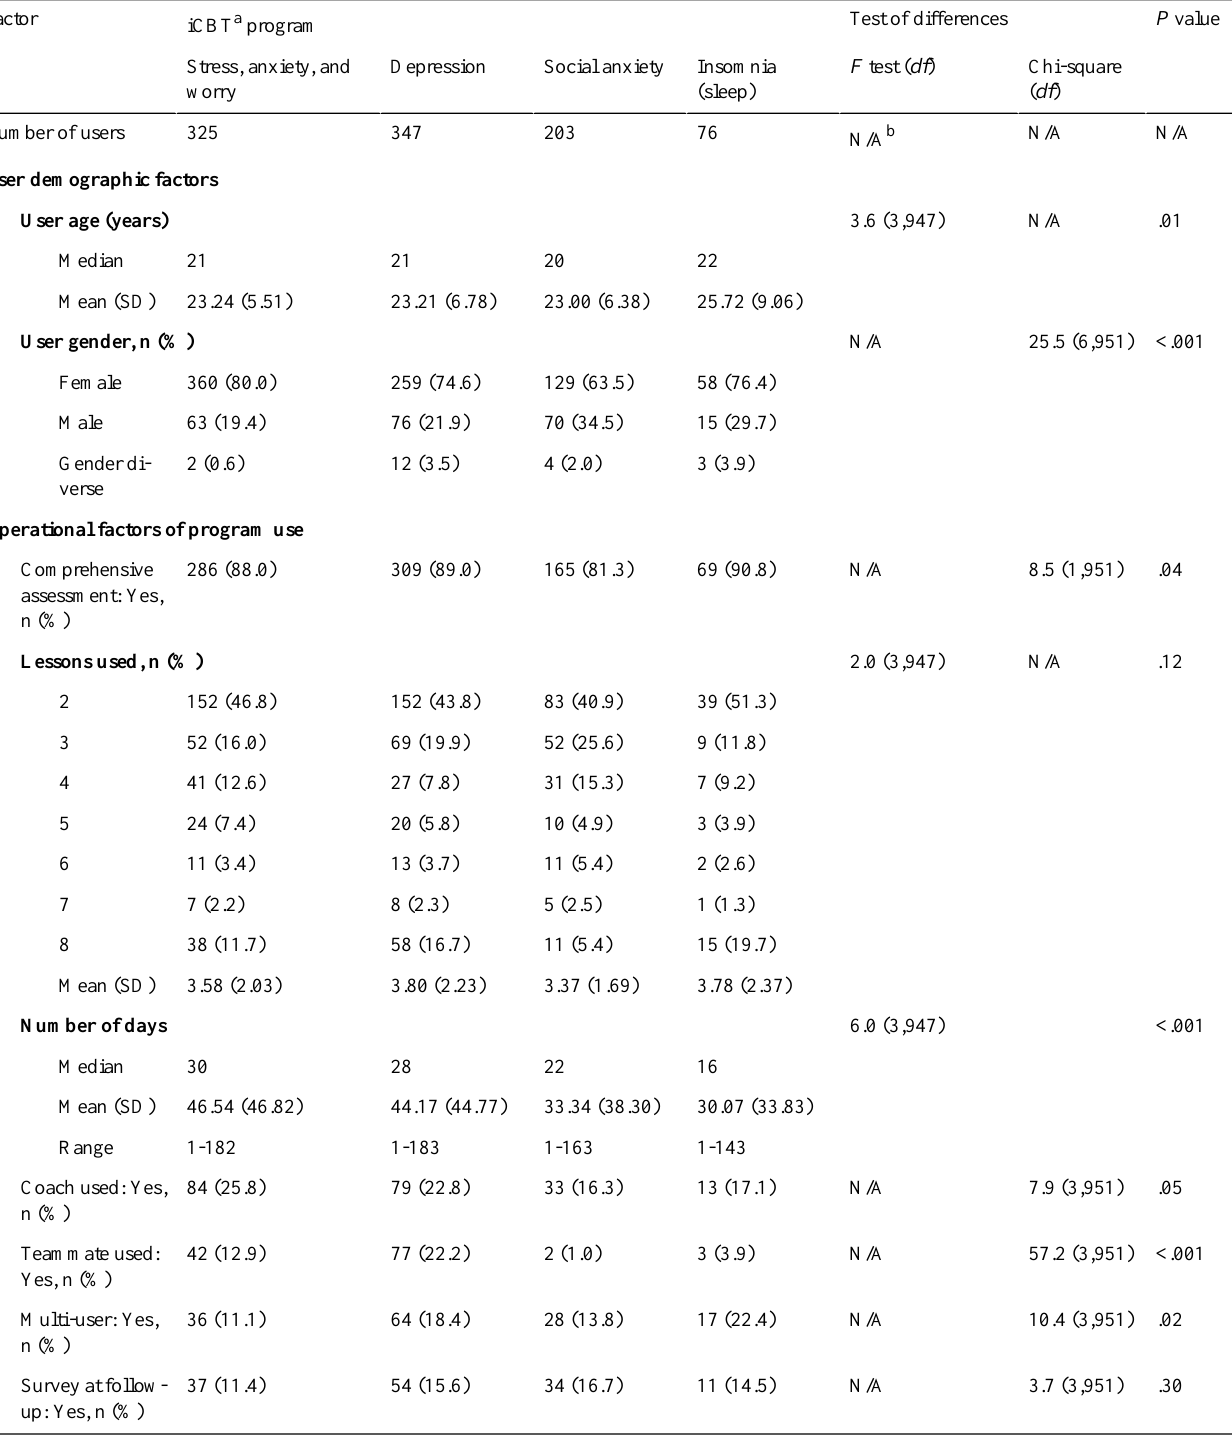
Table 2. Comparison of user demographic and operational factors: The Learn to Live program (N=951).